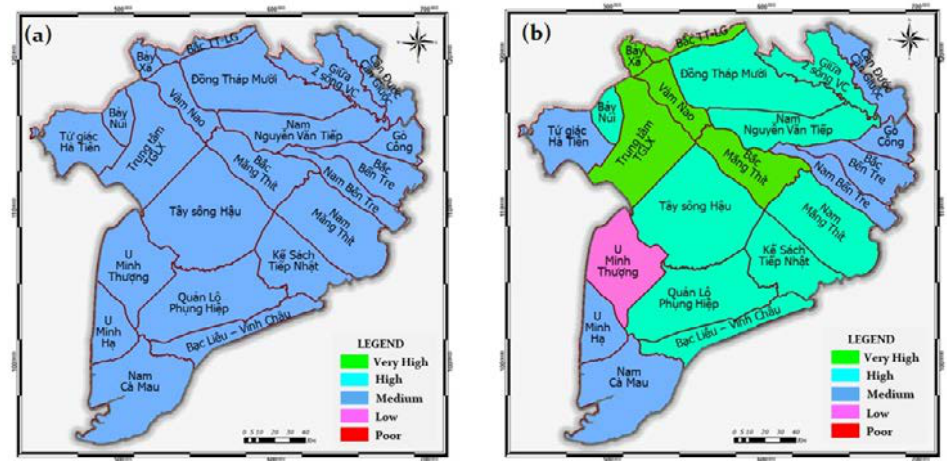
Fig. 2: Maps showing the overall water security index of (a) the water resources dimension and (b) the domestic water supply dimension for each subregion in 2018